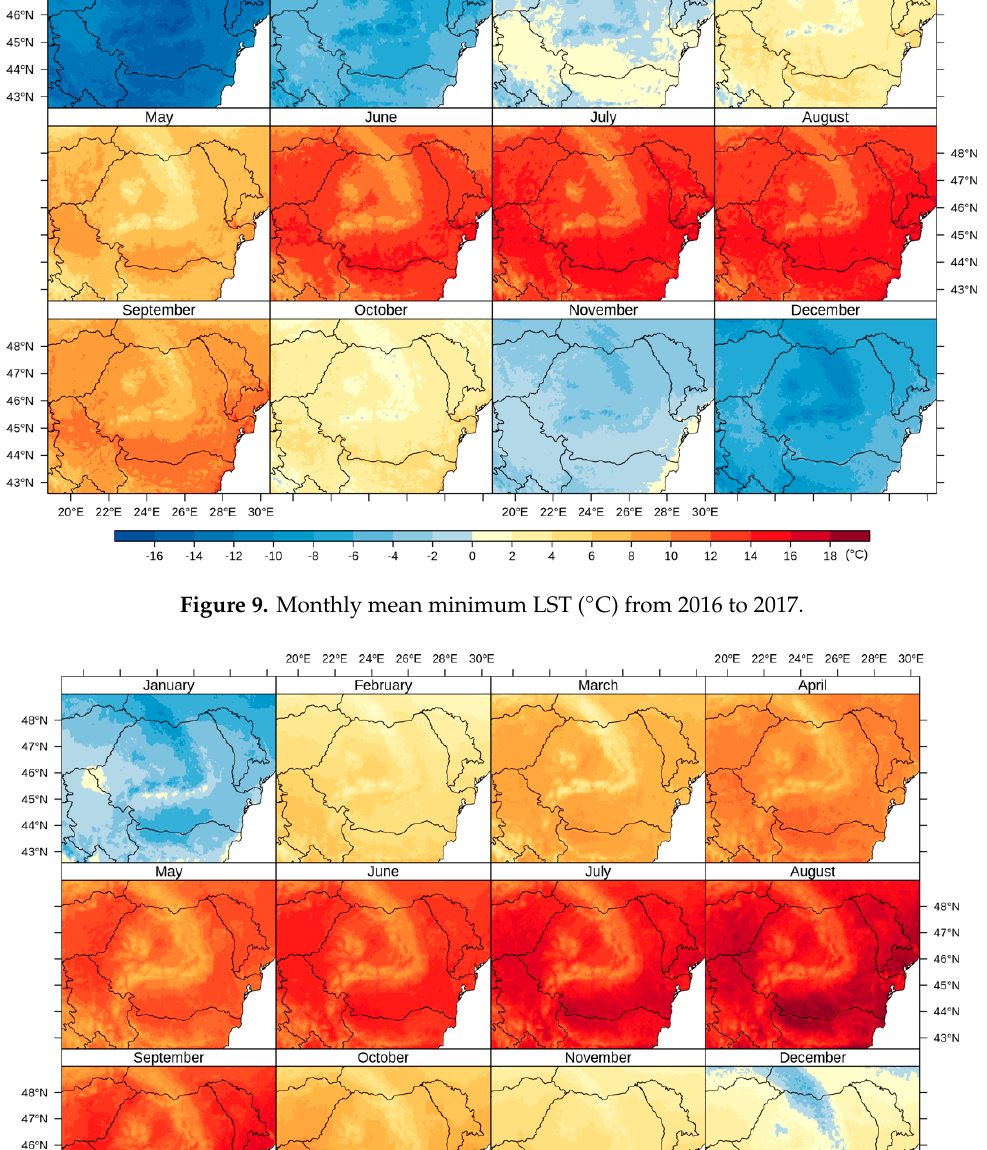
Figure 10. Monthly mean maximum LST (°C) from 2016 to 2017.